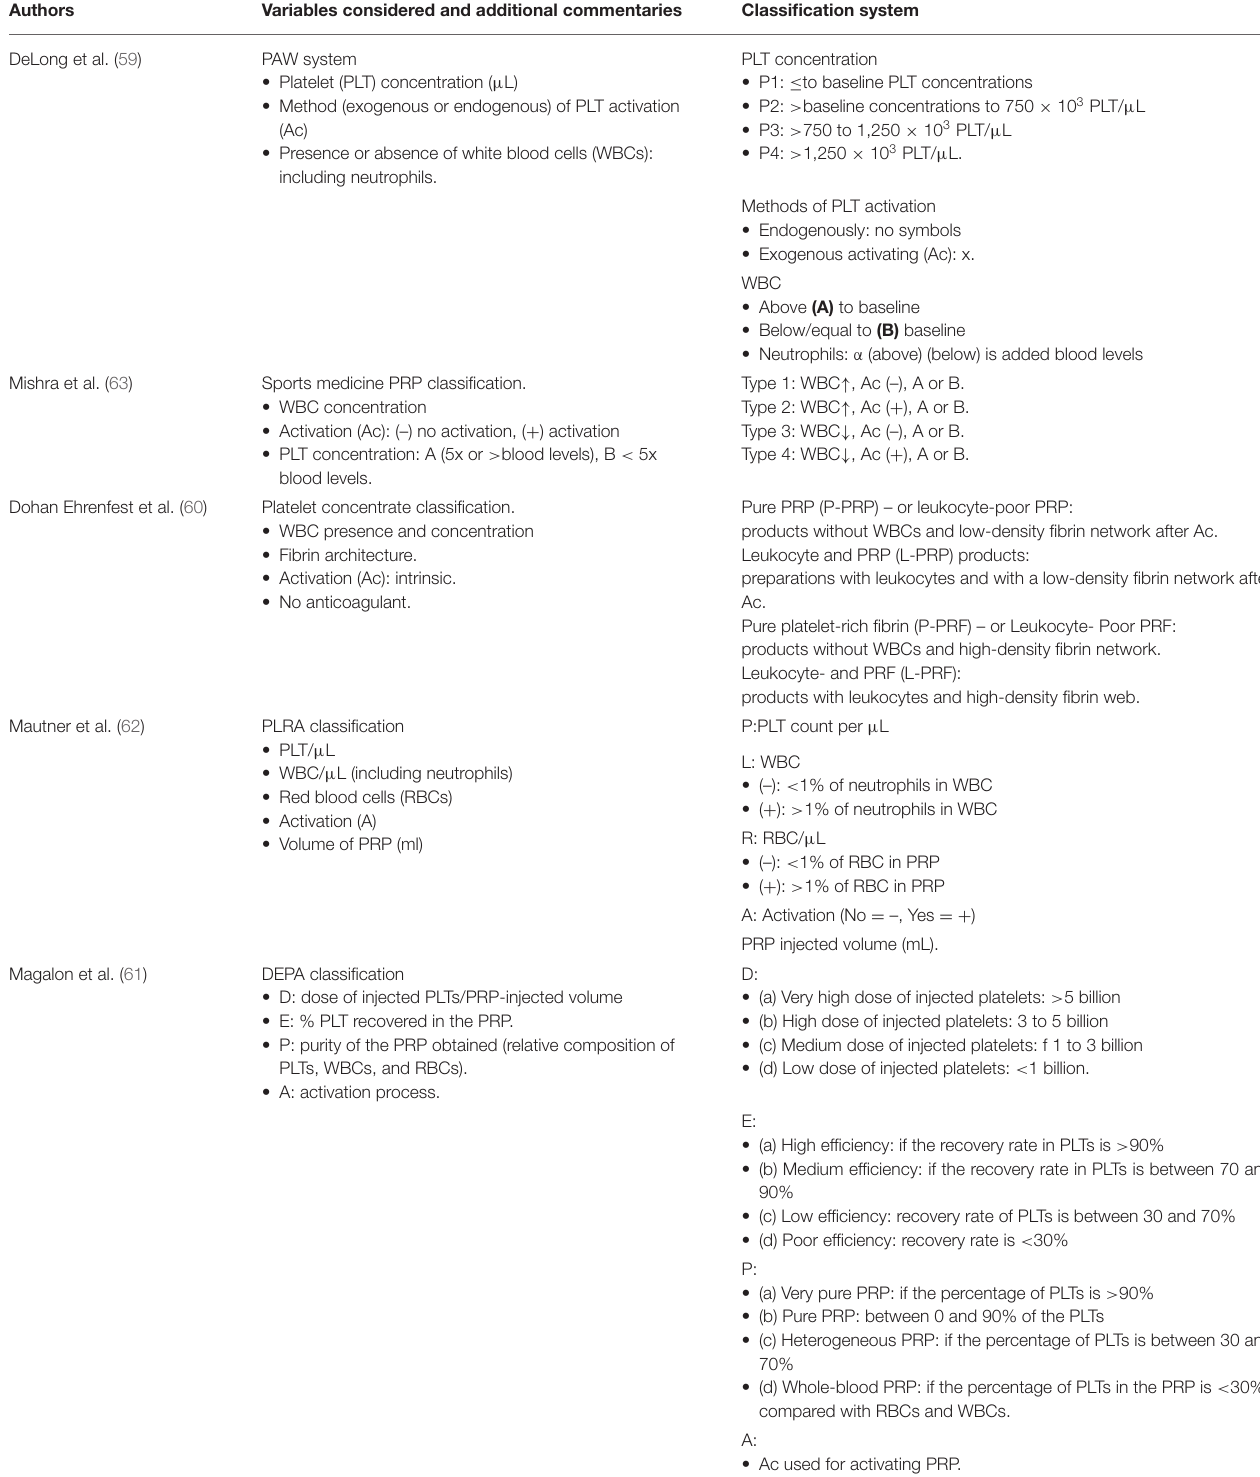
TABLE 1 | Systems proposed for platelet-rich plasma classification in human regenerative medicine (2010–2020).